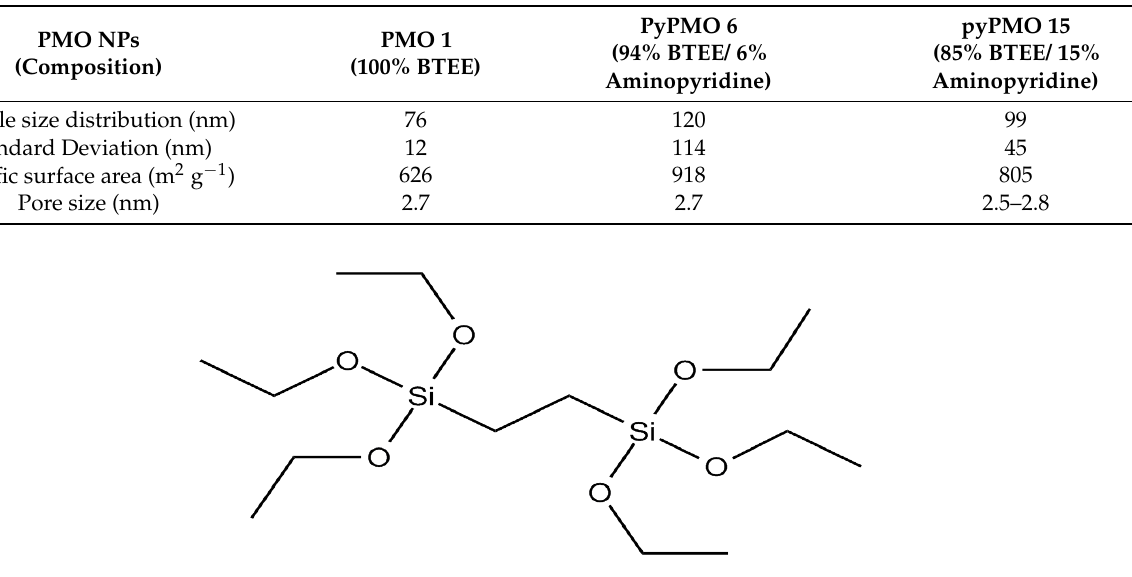
Figure 1. Chemical formula of the 1,2-bis(triethoxysilyl)ethane (BTEE) precursor.